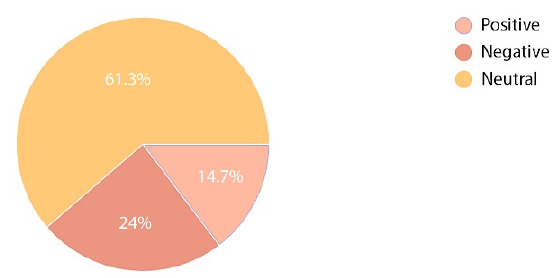
Figure 11. Perception of stay at the hospital—patients.